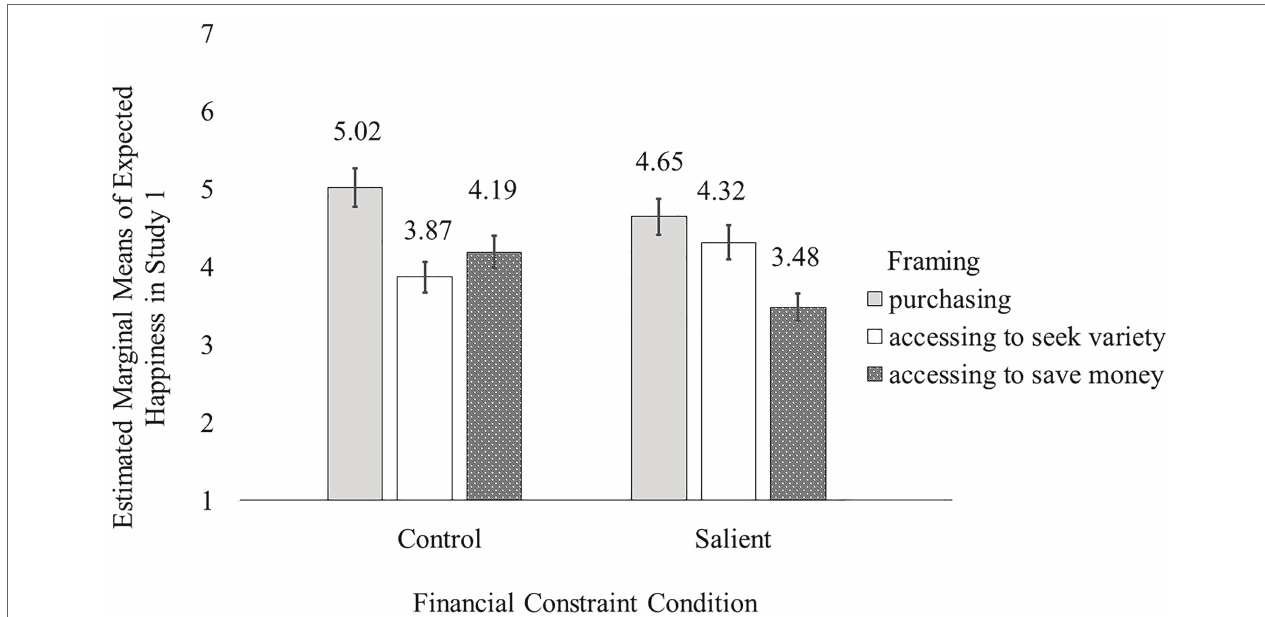
FIGURE 1 | The financial constraints × framing interaction effect on happiness in Study